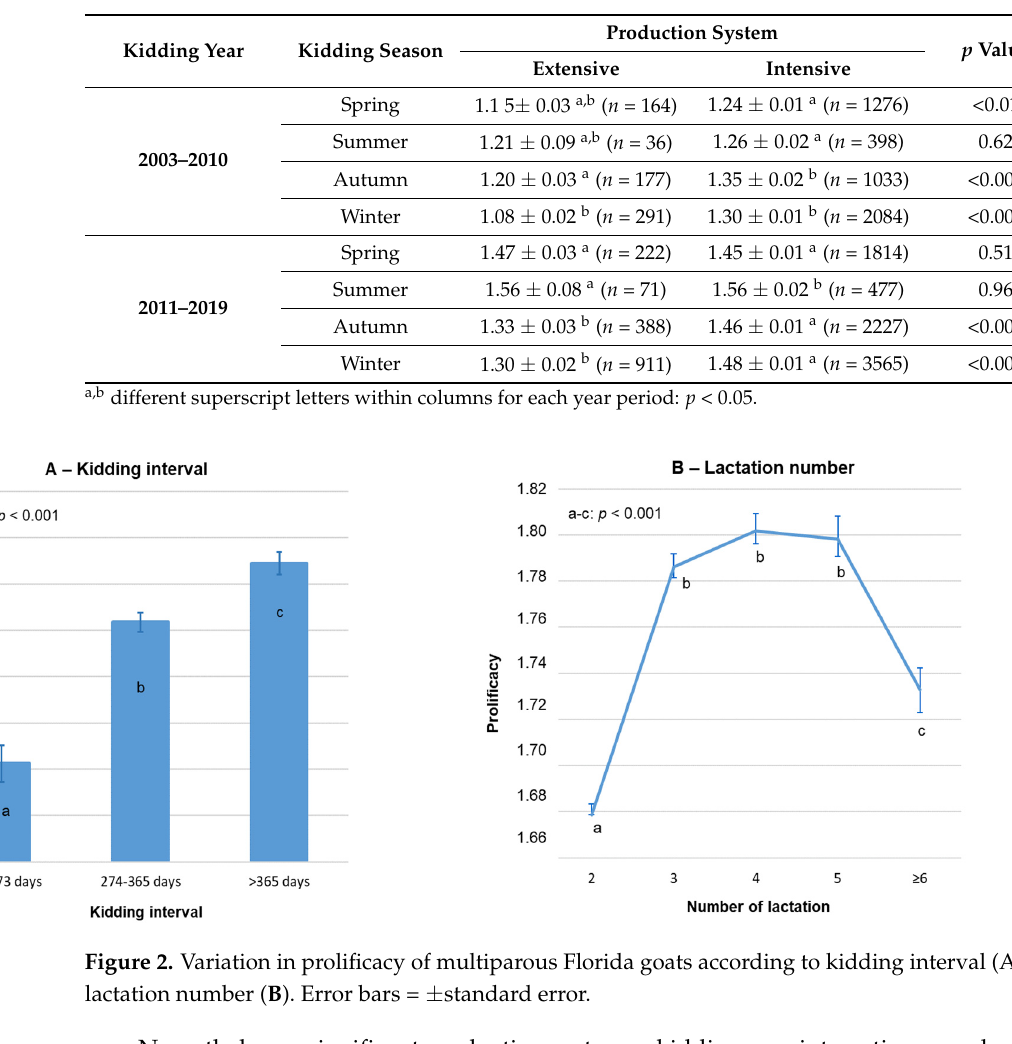
Table 3. Effects of production system and kidding season on prolificacy (mean ± SE) of primiparous Florida goats for two periods of years.